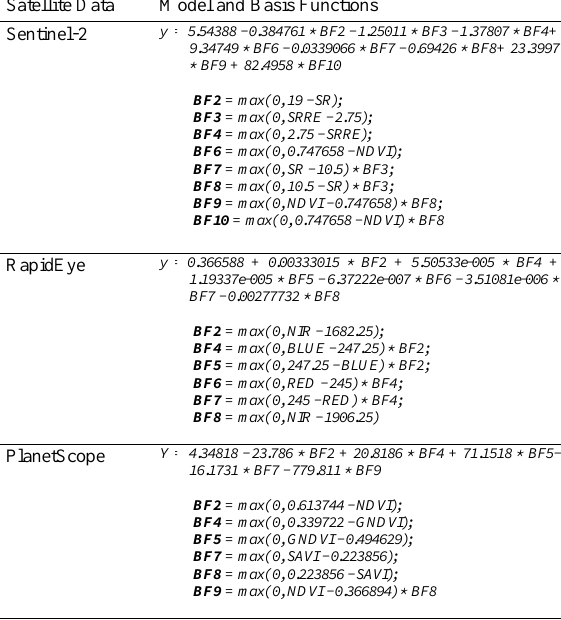
Table 6. Basis functions and final model generated for each satellite data to predict aboveground biomass of mangroves